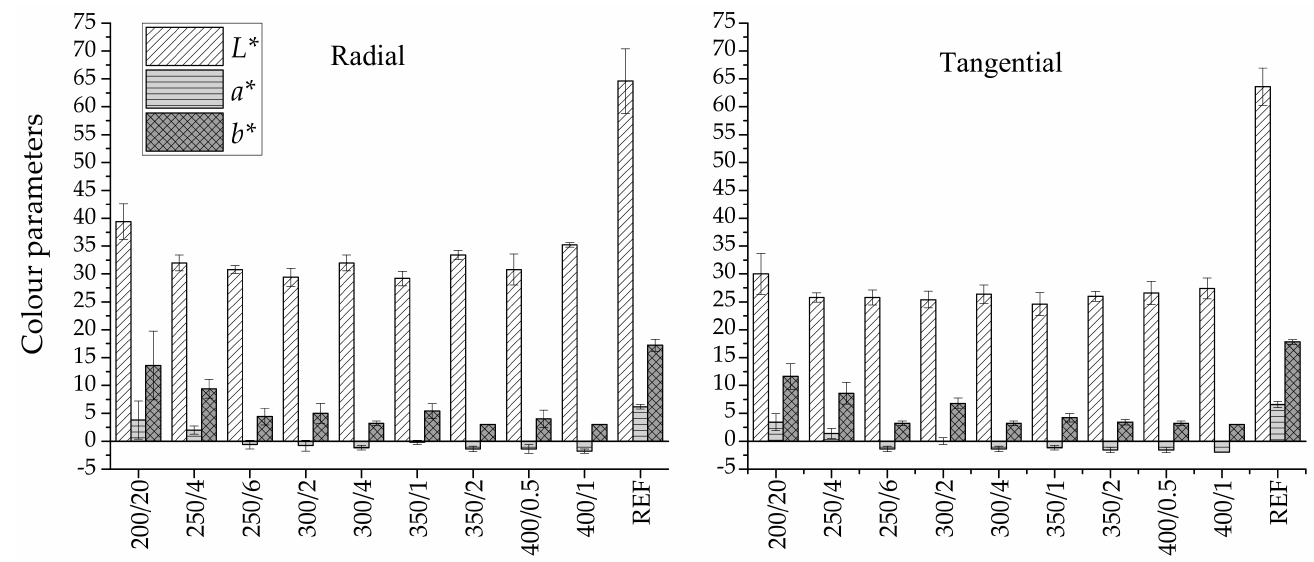
Figure 1. Colour parameters of radial and tangential